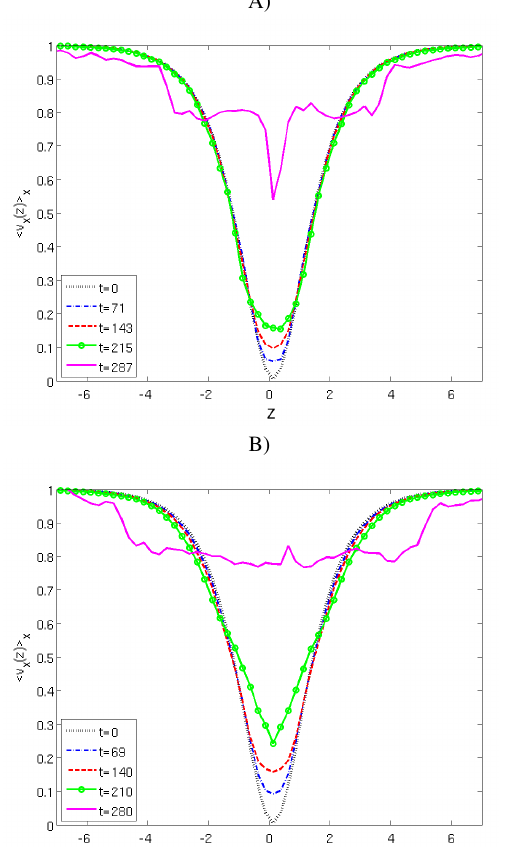
Fig. 4. Evolution of the peak of the average velocity (normalized to the asymptotic speed u 0 ) max z ( < u x ( z ) > x ) (A) and of the reconnected flux (B) for two runs starting from the initial force-free reversed field equilibrium with the same resistivity ( S = 10 4 ) but different viscosity (panel A with R v = 10 4 , panel B R v = 10 3 ).